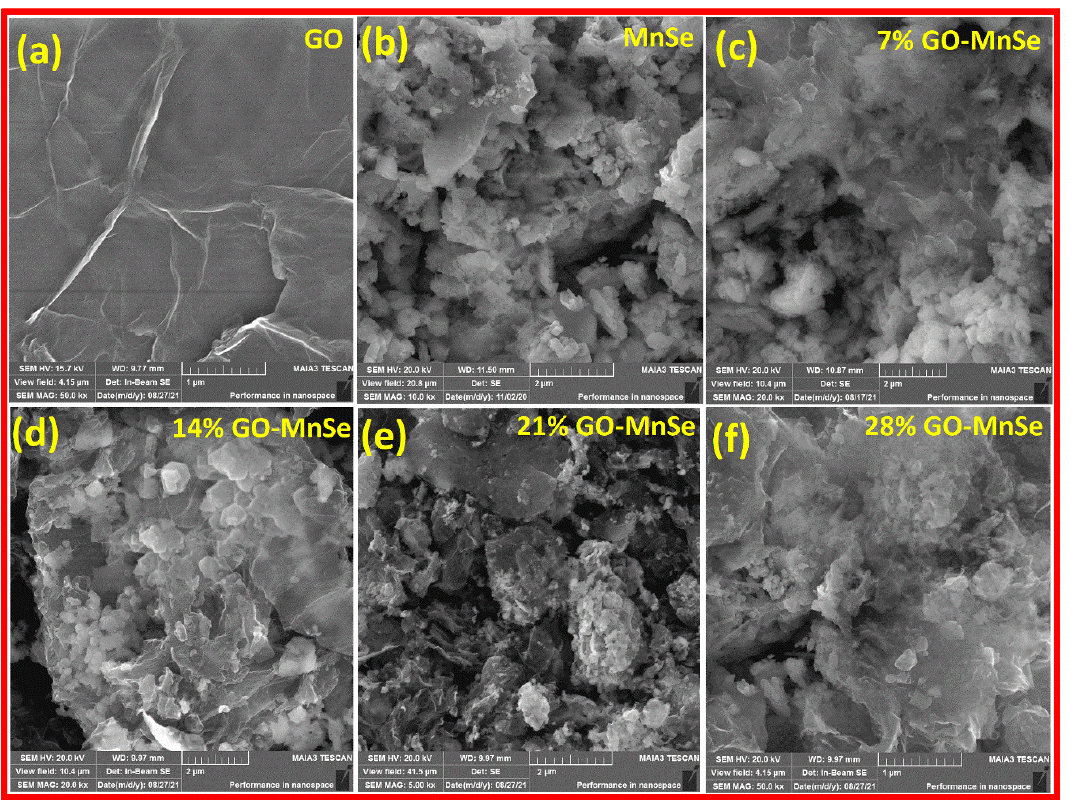
Figure 3. SEM images of ( a ) GO, ( b ) MnSe, ( c ) 7% GO-MnSe, ( d ) 14% GO-MnS, ( e ) 21% GO-MnSe, and ( f ) 28% GO-MnSe.